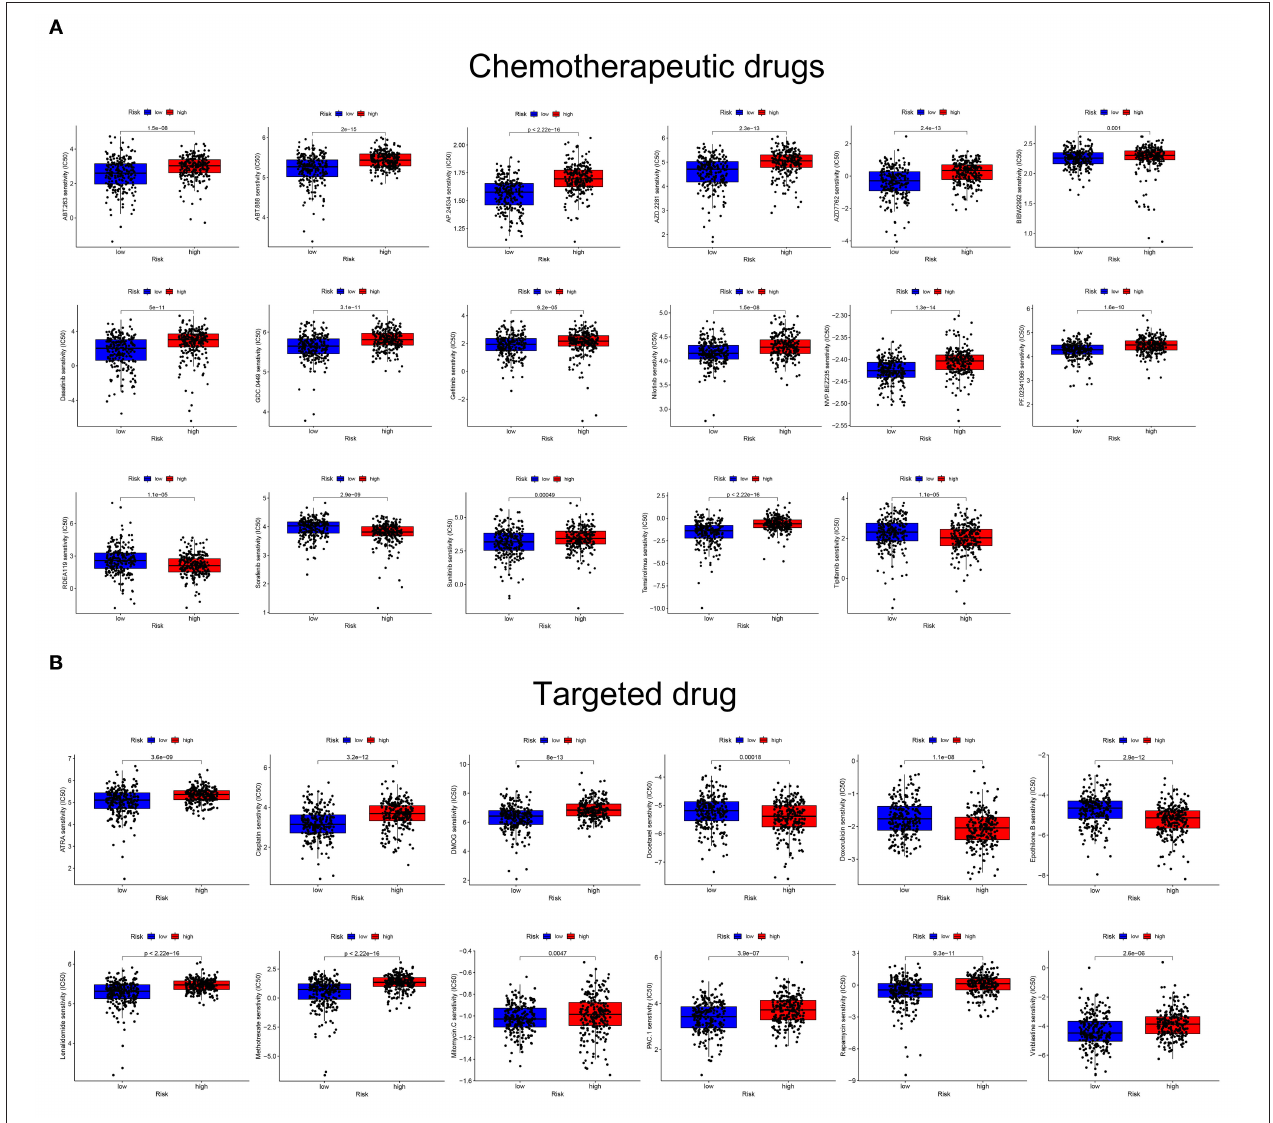
FIGURE 9 | The GRIP signature is associated with chemotherapy and targeted therapy sensitivity. (A) The risk score was related to higher IC50 values of targeted agents. (B) The risk score was related to higher IC50 values of chemotherapeutic